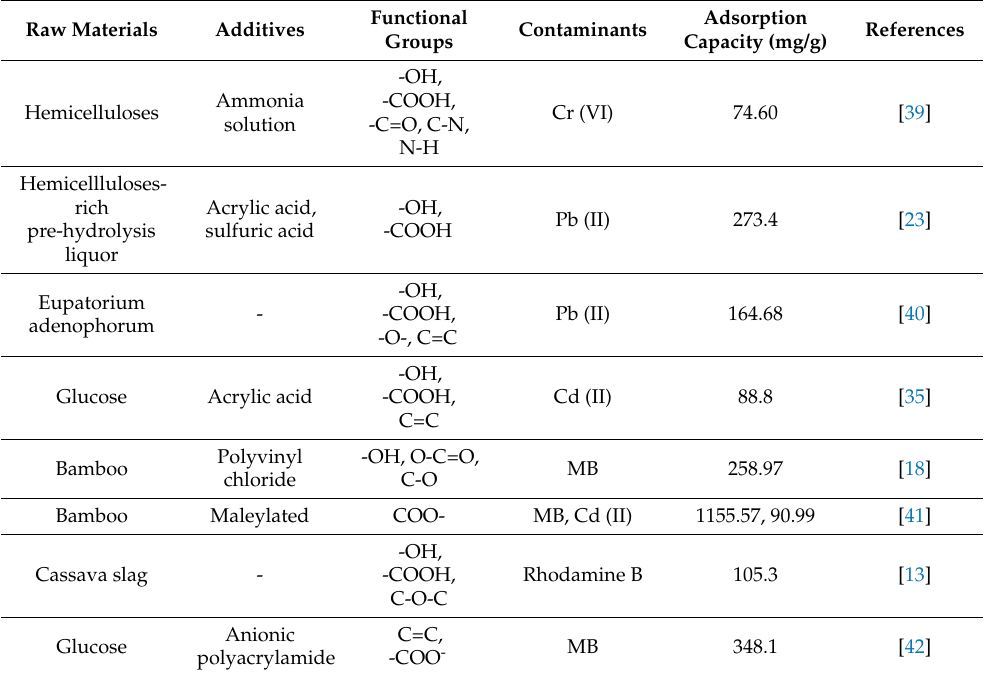
Table 1. Adsorption capacity of biomass-based hydrothermal